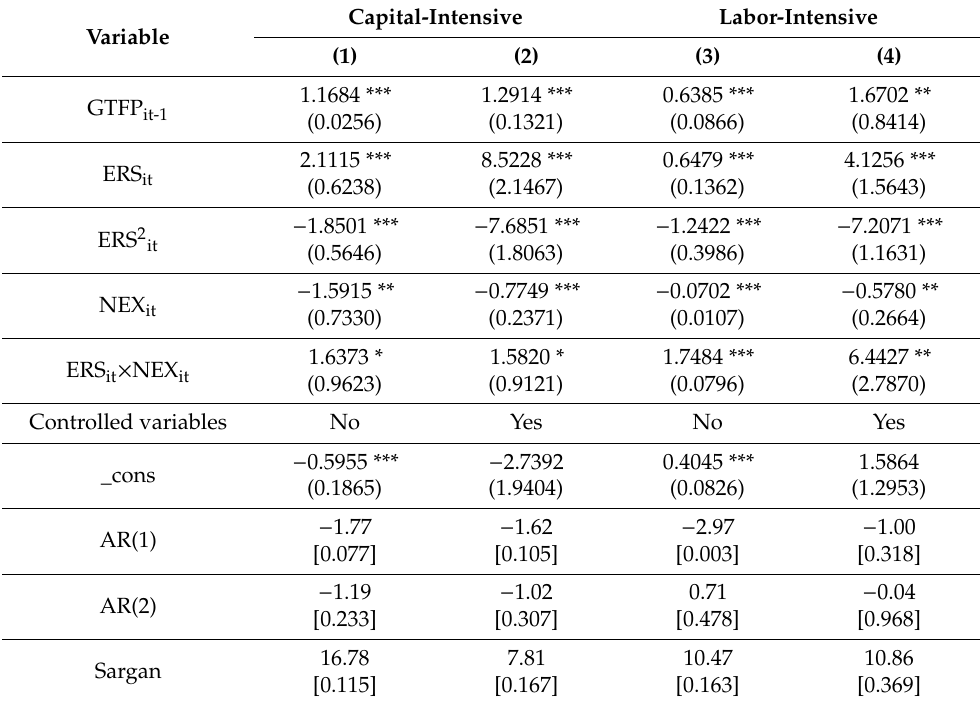
Table 5. Estimated results grouped by factor